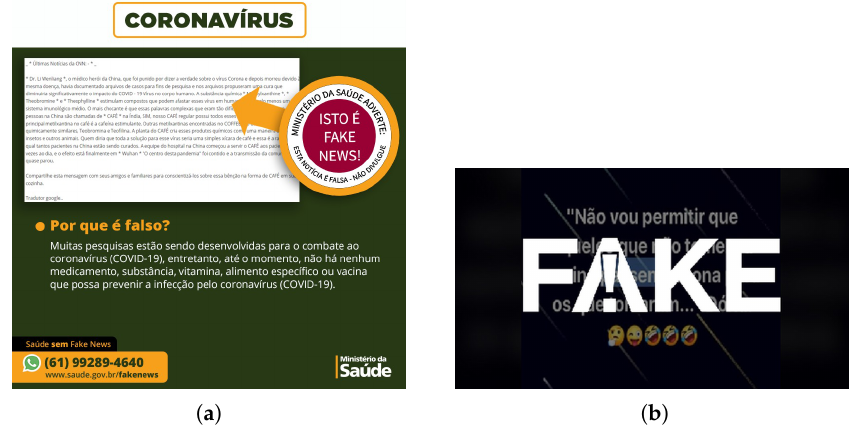
Figure 1. Examples of how fake news is presented by ( a ) the Saúde sem Fake News [21] and ( b ) Fake ou Fato